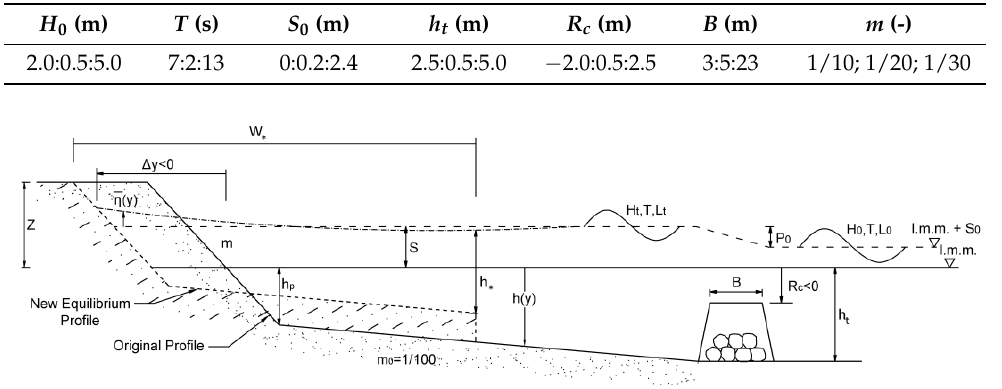
Table 1. Summary of the tested values for each parameter.